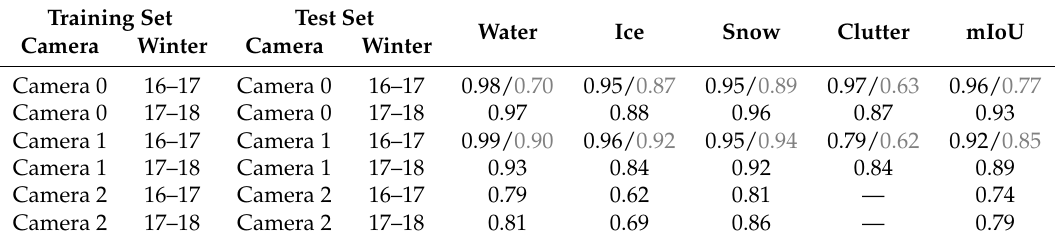
Table 15. Results (IoU) of same camera train/test experiments. We compare our results with Tiramisu Network [34] (shown in grey). Cameras 0 and 1 monitor lake St. Moritz while camera 2 captures lake Sihl.